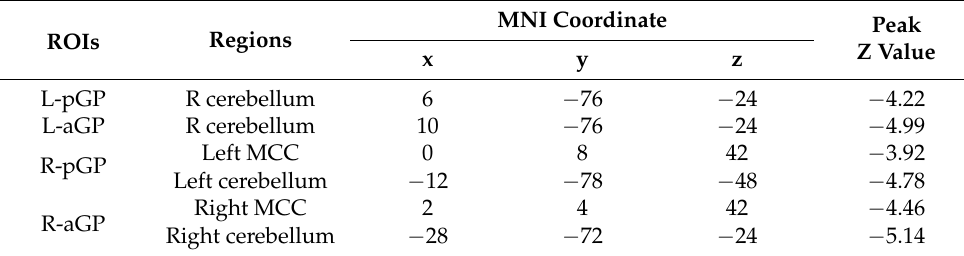
Table 3. Group FC differences in the globus pallidum between WD patients and HCs. ROIs